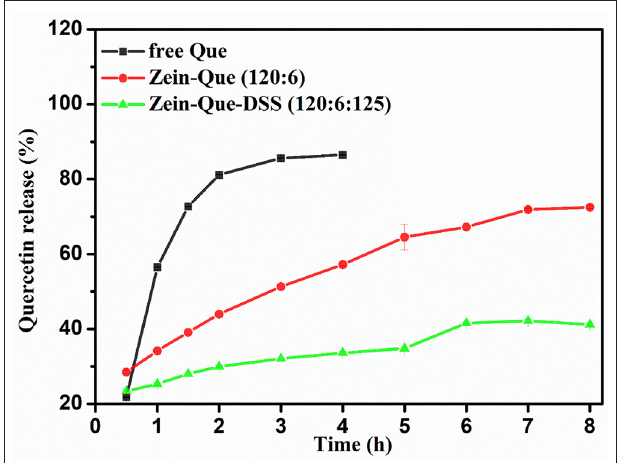
FIGURE 6 | Kinetic release profile of free Que and Que obtained from Zein-Que (120:6) nanoparticles and Zein-Que-DSS (120:6:125) complex nanoparticles under stimulated intestinal conditions (pH = 6.4) at 37 ◦ C.